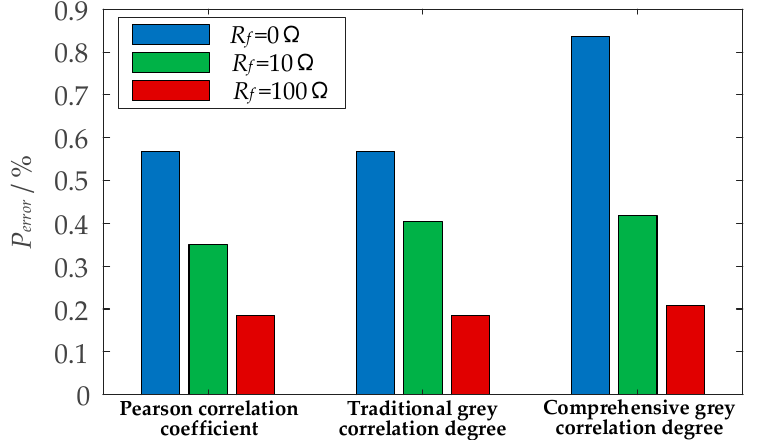
Figure 11. Simulation results for pole-to-pole short-circuit under three algorithms.